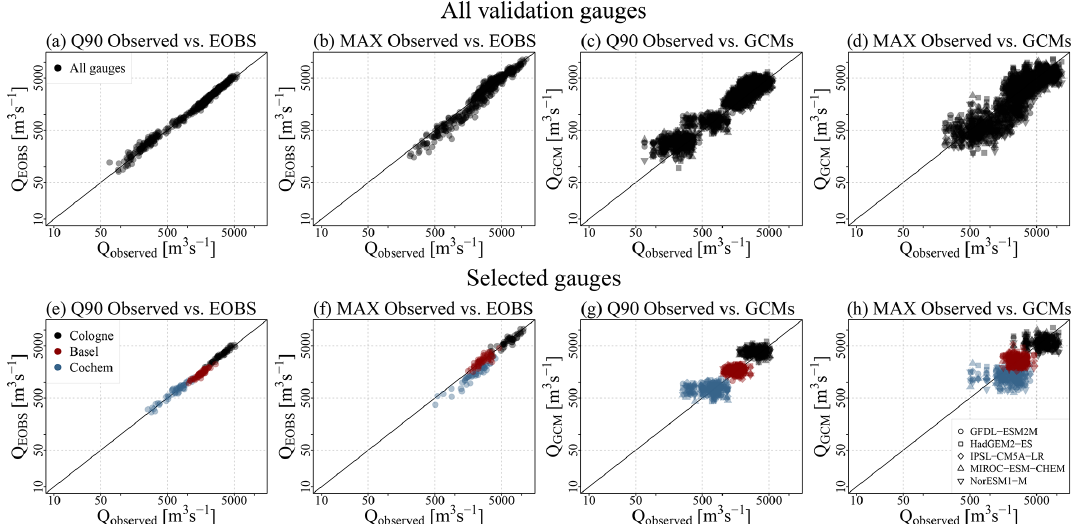
Figure A1. Scatter plot of observed and simulated annual streamflow maxima (MAX) and the 90% streamflow quantile ( Q 90) of the hydrological year starting 1 October for all validation gauges ( a–d ; Fig. 2) and for selected gauges (e–h) . Panels (a) , (b) , (e) and (f) depict observed discharge and simulated discharge using E-OBS-based meteorological forcing. Panels (c) , (d) , (g) and (h) depict observed discharge and simulated discharge using climate model data from the ISI-MIP project. Time frame investigated: 1951–2000.